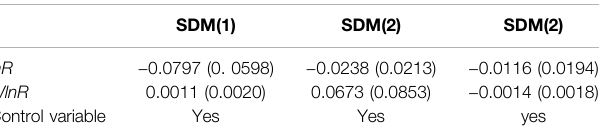
TABLE 6 | Placebo